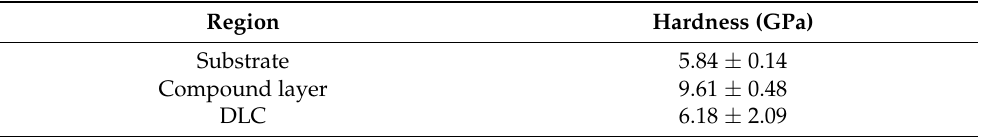
Table 5. Comparison of hardness values for substrate, compound nitrided layer (HV 0.1 ) and DLC (nanoindentation).